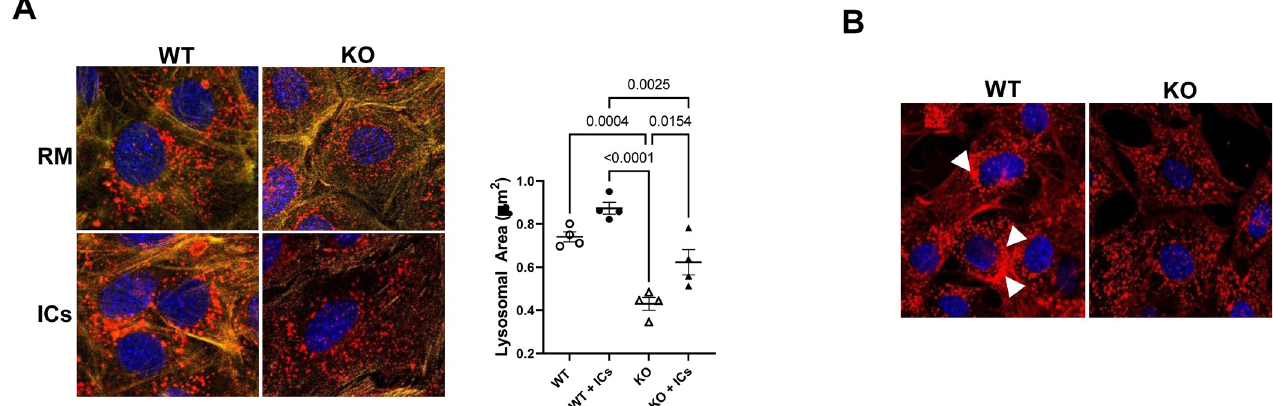
Fig 2. Lysosomal area is significantly decreased and lysosomal distribution is altered in FcRn KO podocytes compared to WT after treatment with immune complexes. A , Lysosomal area is decreased in KO podocytes at baseline and after treatment with ICs. RM, regular media; ICs, immune complexes. Lysosomes are stained red, nuclei are blue, actin is yellow. Symbols represent mean surface area for lysosomes in 20 different cells per experiment, n = 4 independent experiments. B , Treatment with ICs results in perinuclear clustering of lysosomes in WT podocytes (arrows) but not KO. Lysosomes are stained red.